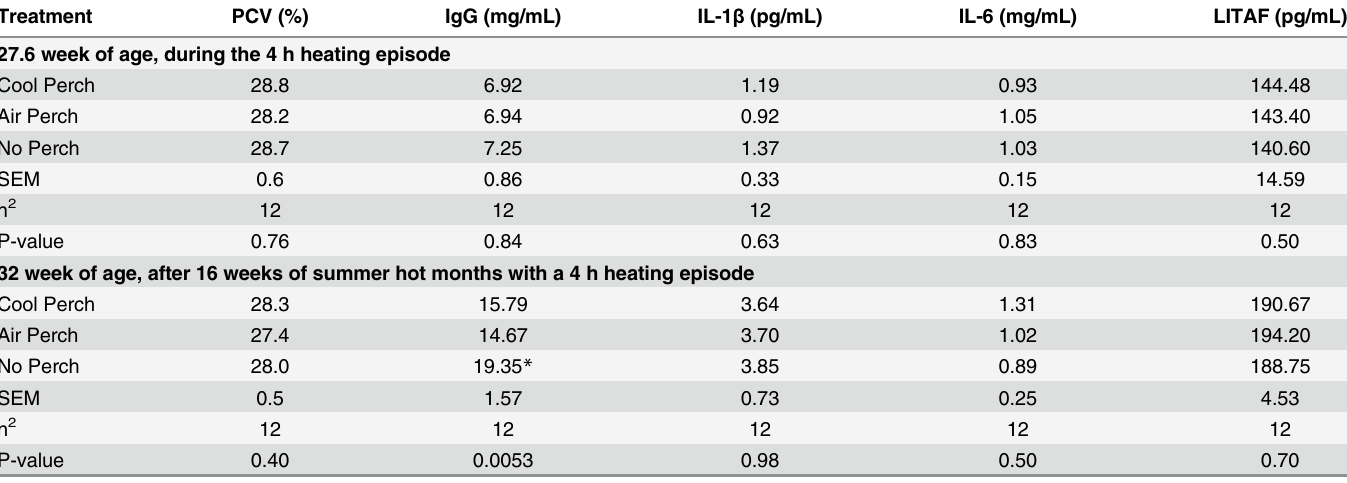
Table 3. The effect of thermally cool perch availability on PCV, plasma IgG and cytokine concentrations of White Leghorn hens at 27.6 and 32 week of age 1 . Treatment